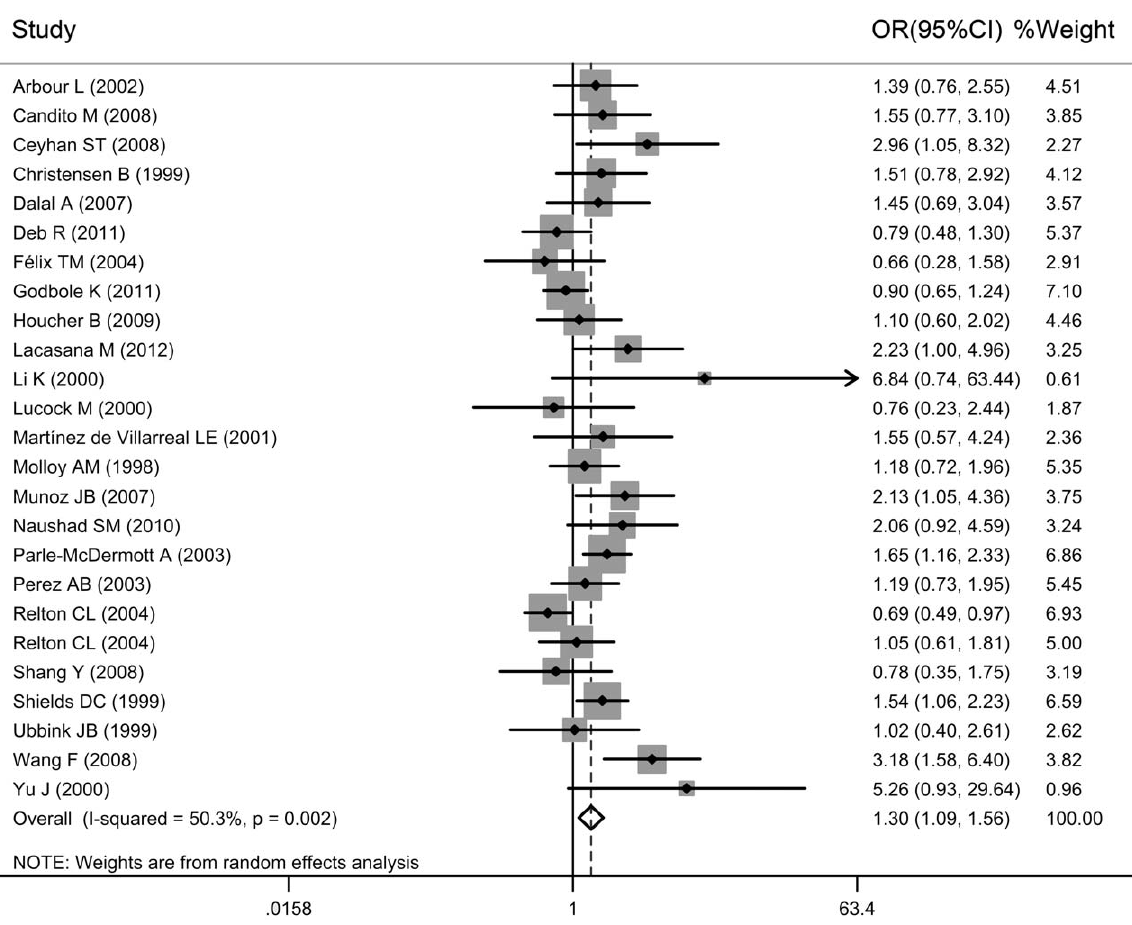
Figure 2. Forest plot of NTD risk associated with the maternal MTHFRC677T polymorphism (TT + CT vs. CC) in overall populations.